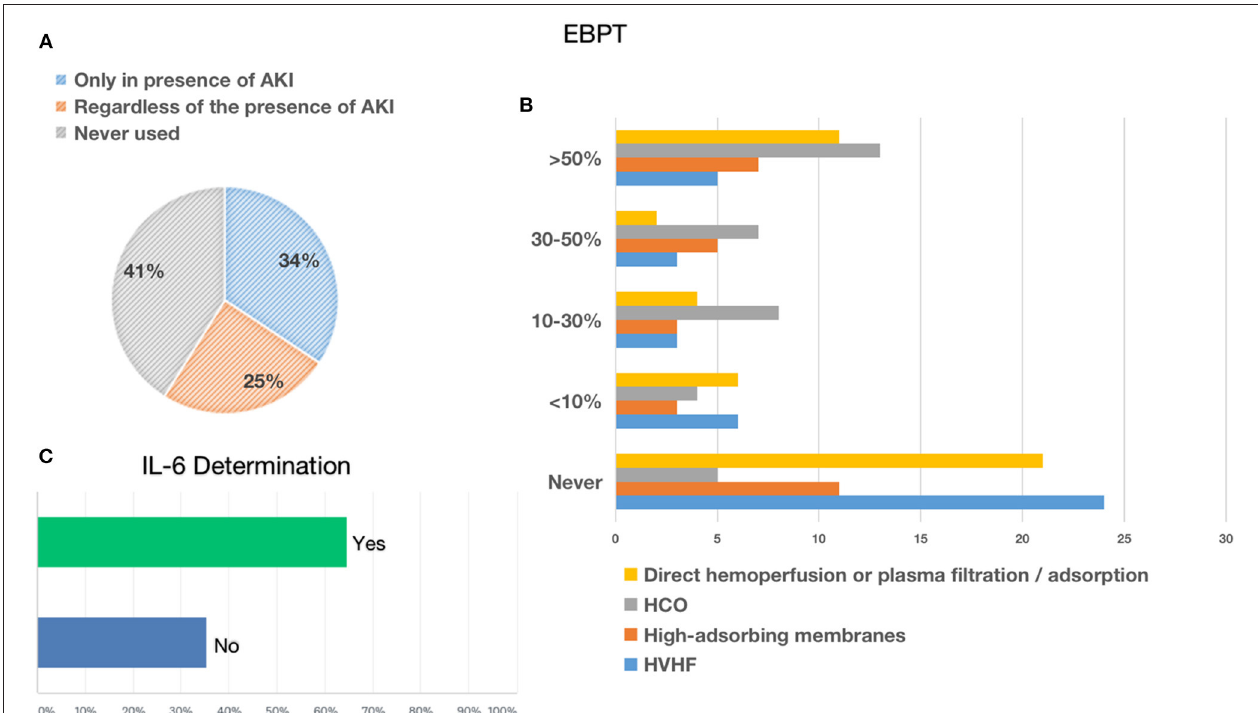
FIGURE 1 | Acute kidney injury. (A) Shows the percentage of underestimation of acute kidney injury (AKI) referred only to patients who needed RRT. (B) Shows the use of AKI definition criteria (AKIN, KDIGO, RIFLE, etc.) to classify AKI in patients with COVID-19. (C) Shows the use of urinalysis or biomarkers for AKI in patients with